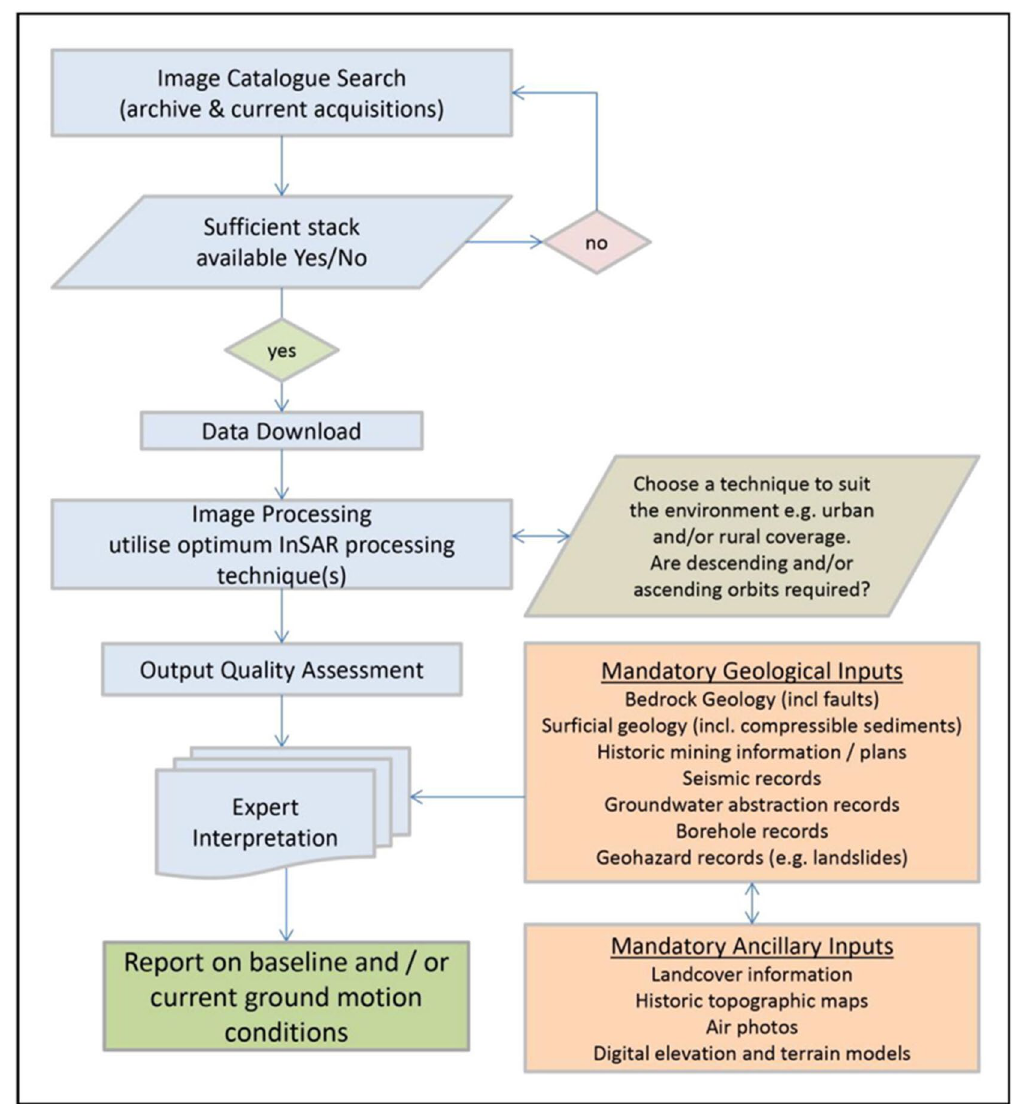
Figure 8. Flowchart of the approach and data utilised for the ground motion InSAR monitoring 6